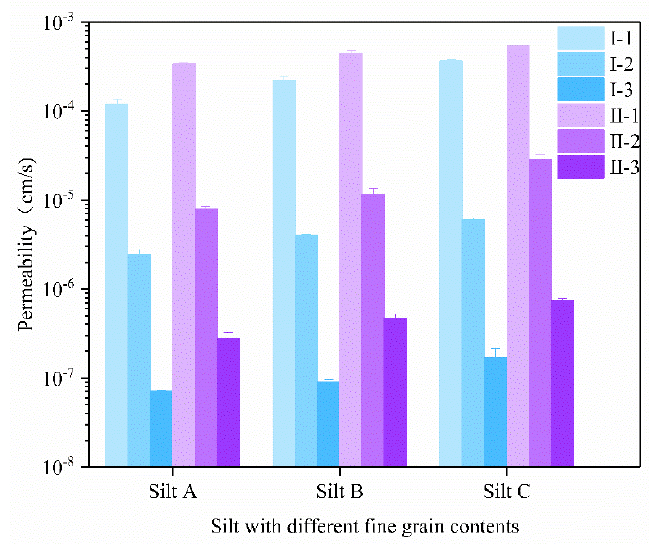
Figure 15. Effect of different fine particle content on permeability coefficient.